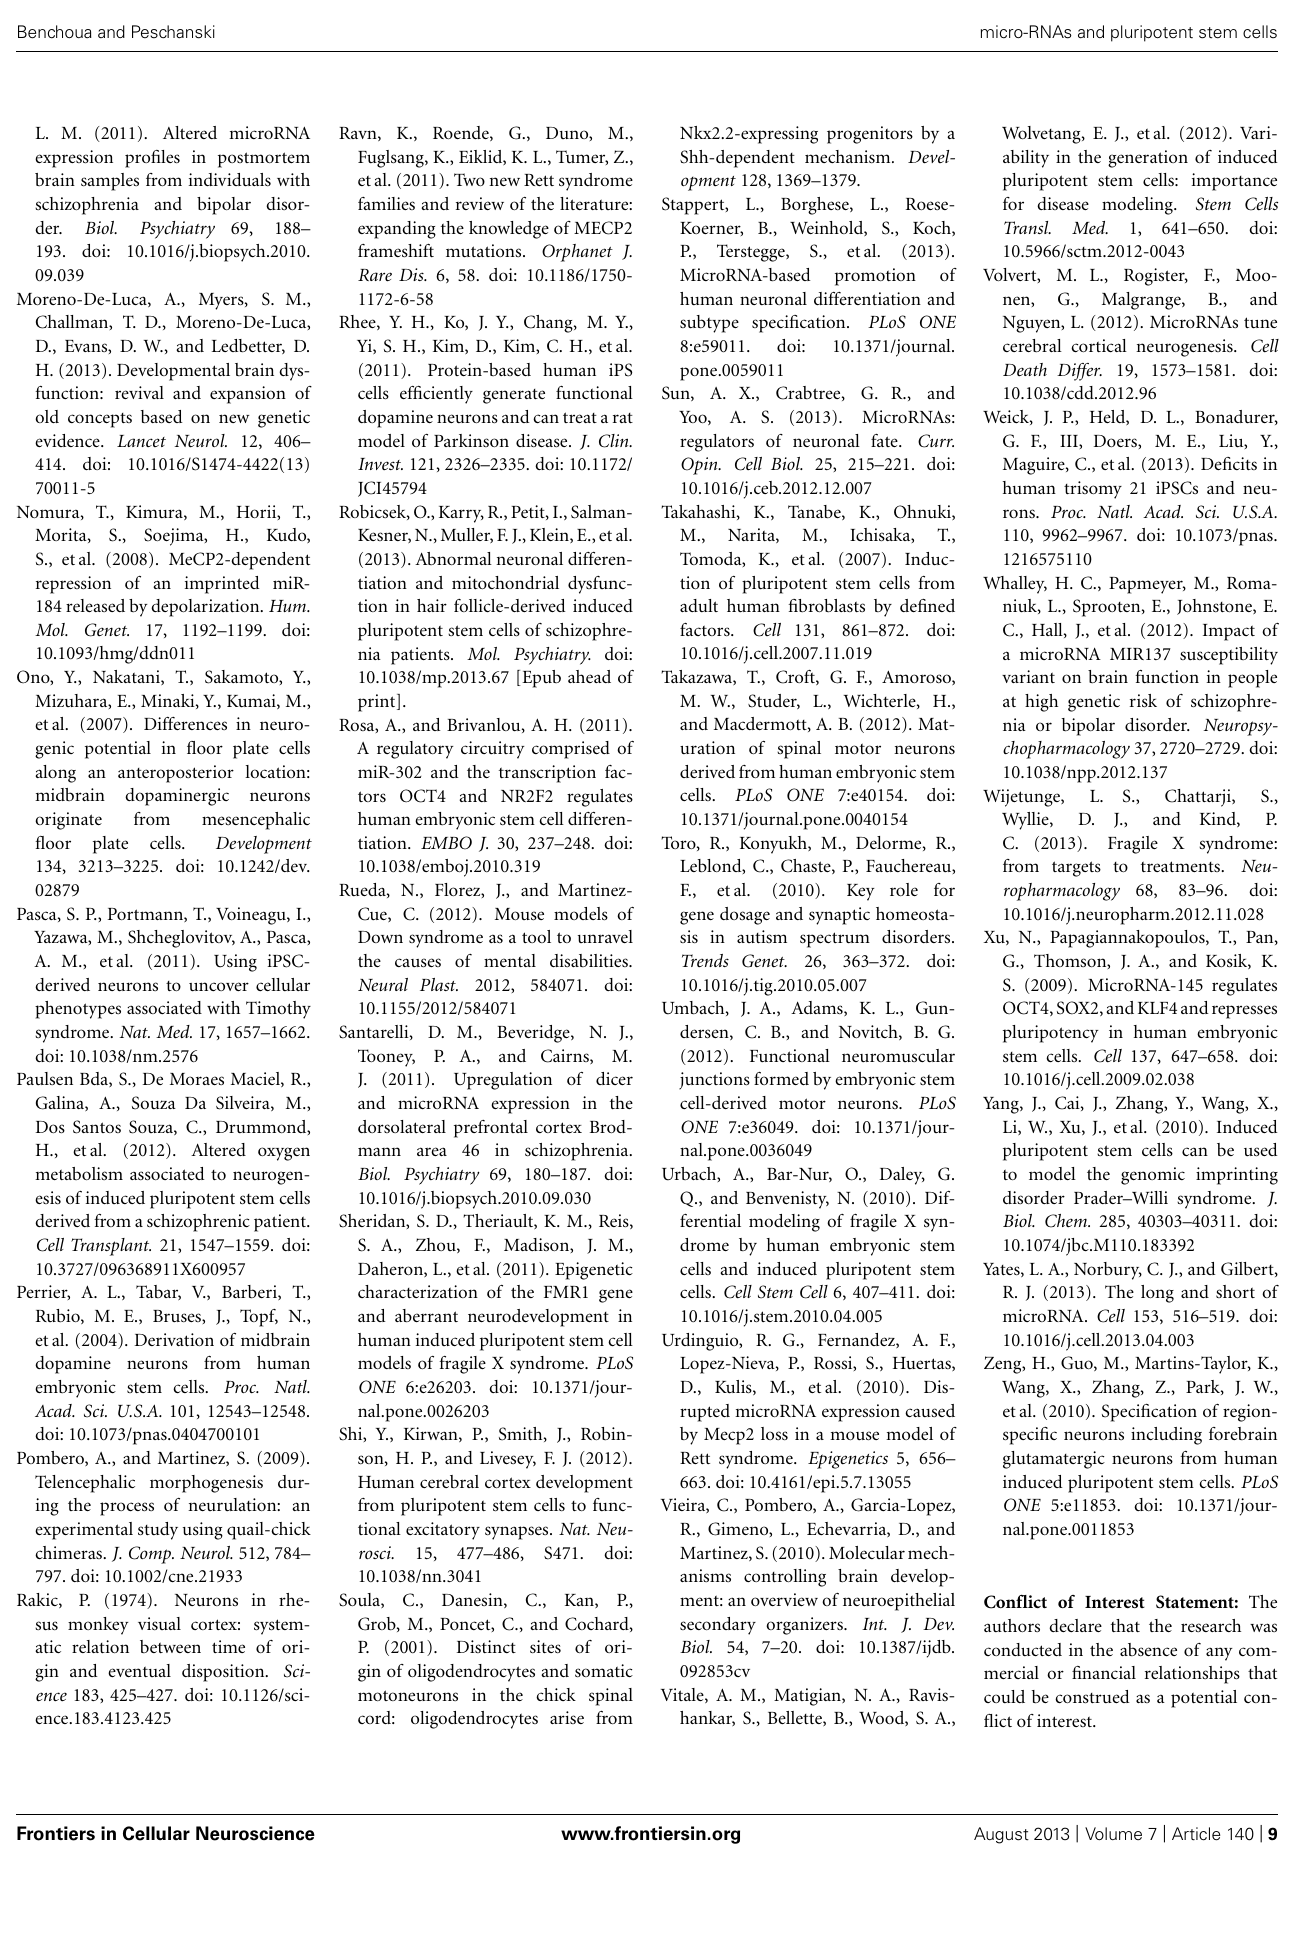
ONE 5:e11853. doi: 10.1371/jour- nal.pone.0011853